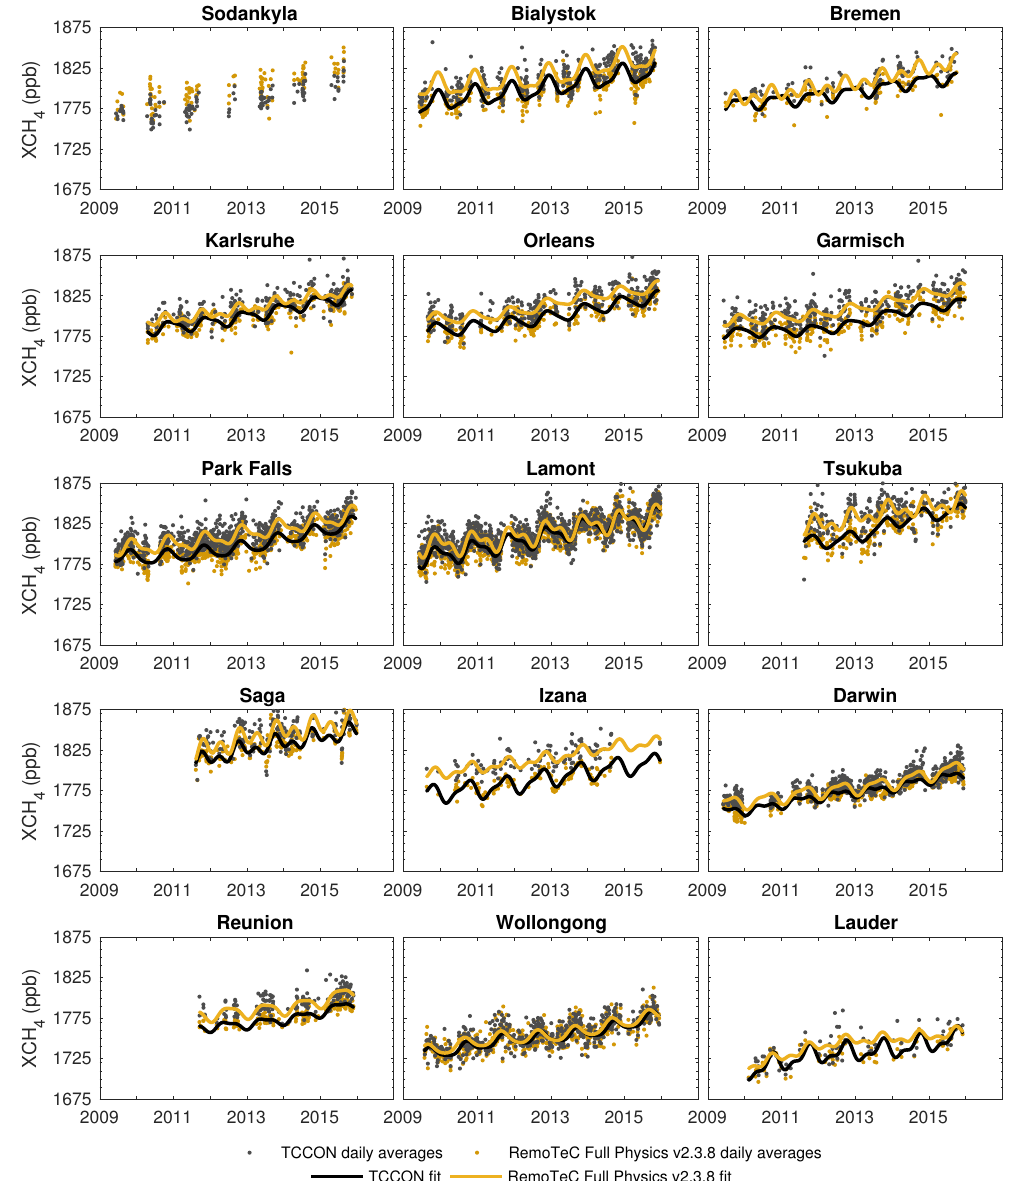
Figure A2. Daily averages and DLM fits of XCH 4 for RemoTeC Full Physics v2.3.8 retrieval algorithm at the TCCON sites. The sites are arranged by their latitude from the northernmost (Sodankylä) to the southernmost